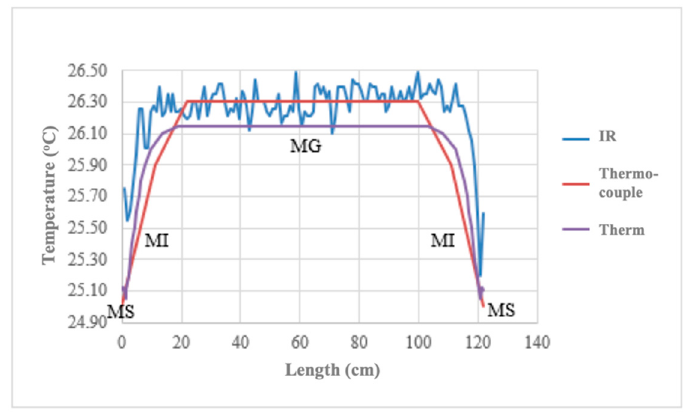
Figure 7. Comparison of thermocouple, IR and THERM software temperature distributions.